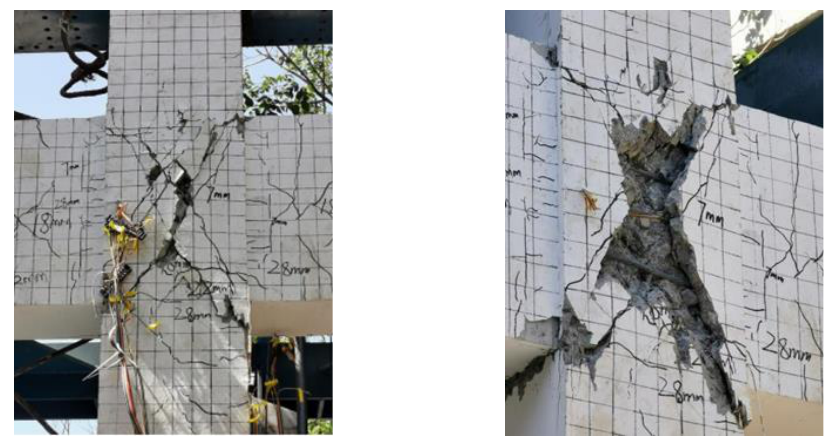
( c ) Failure mode Figure 13. Crack development and failure of specimen ZJ-2A. (4) Specimen ZJ-3 For specimen ZJ-3, the first diagonal crack appeared in the joint core when the dis- placement was loaded to 6 mm. When the displacement reaches 18 mm, cross cracks are formed in the core, with the widest cracks of 0.9 mm, and when the displacement reaches 24 mm, several new minor cross cracks are added to the core. At this stage, the bending and shear cracks in the beams are developing rapidly, with cracks extending to one-half of the beam height. When the displacement reaches 36 mm, the main cracks expand and